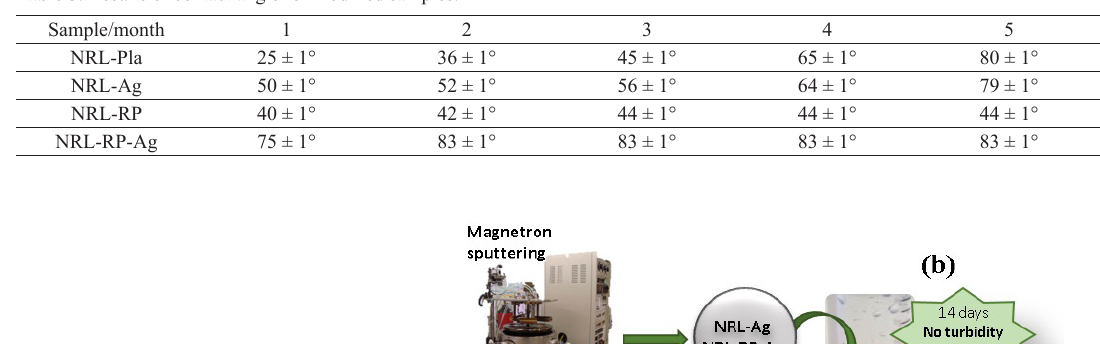
Table 5. Results of contact angle for modified